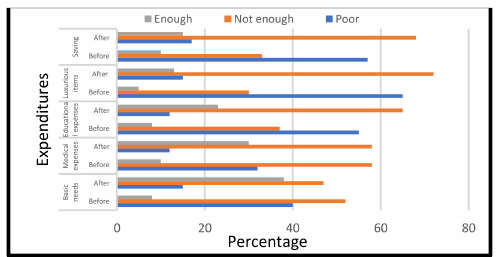
Figure 14. Changes in economic status of the vegetable seed